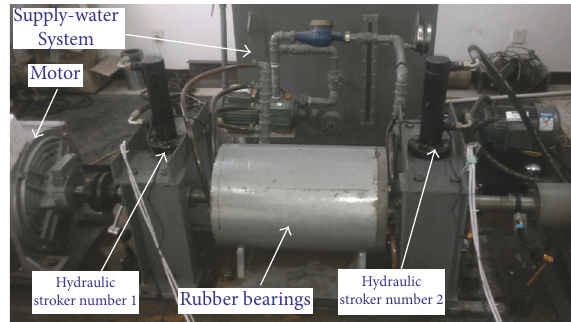
Figure 2: Photograph of the test